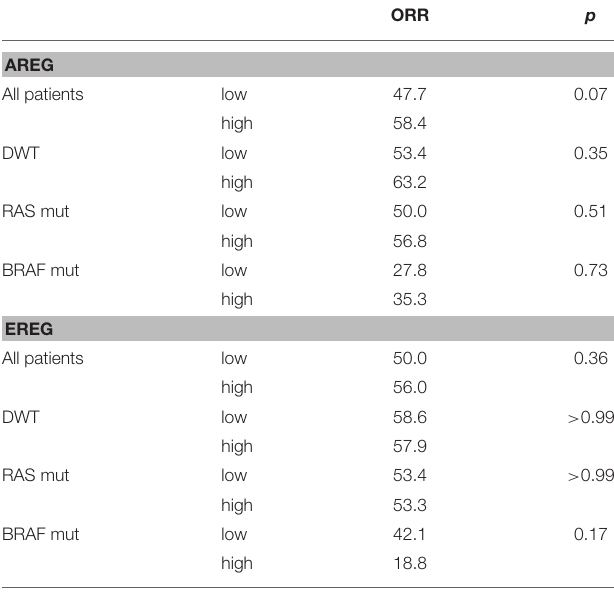
TABLE 2 | Overall response rate (ORR) in dependence of AREG and